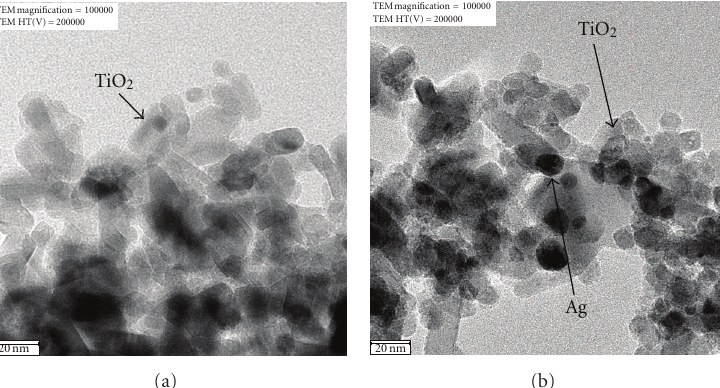
Figure 3: TEM micrographs of the TiO 2 nanotubes (a) before and (b) after immersion in the AgNO 3 solution with UV exposure for 120 minutes.